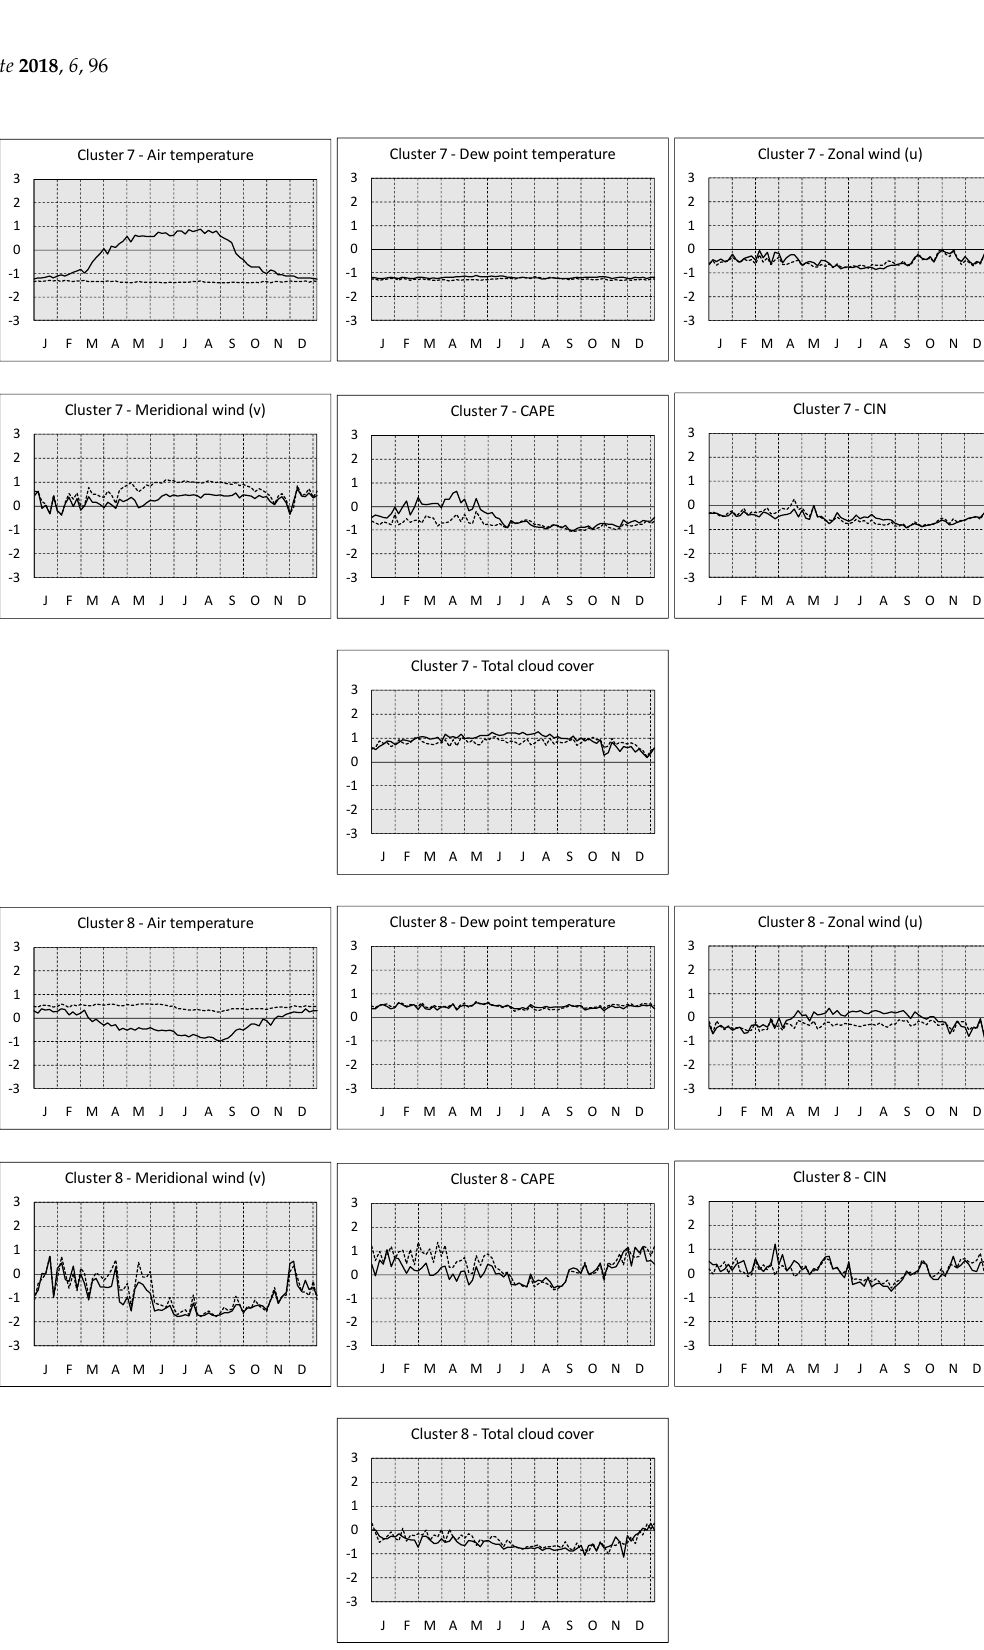
Figure 7. As in Figure 4, but for clusters 7 and 8.